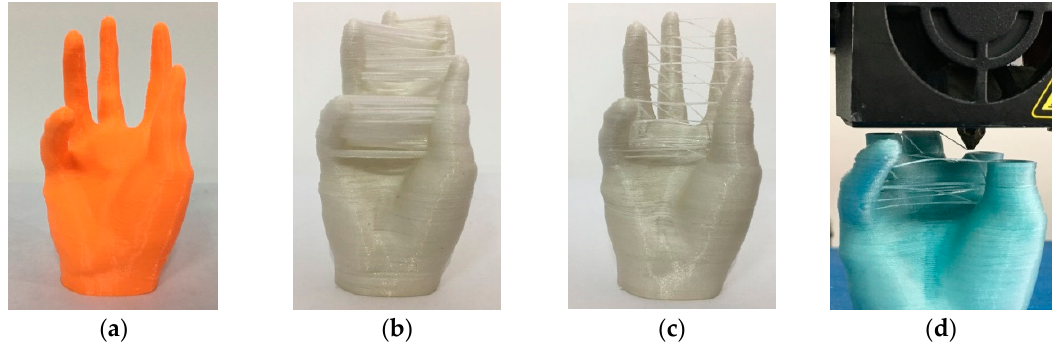
Figure 4. Multiple branches structure printing. ( a ) PLA with a normal path. ( b ) PFRTPCs with a normal path. ( c ) PFRTPCs with an optimized path. ( d ) Printer nozzle travels across open space.